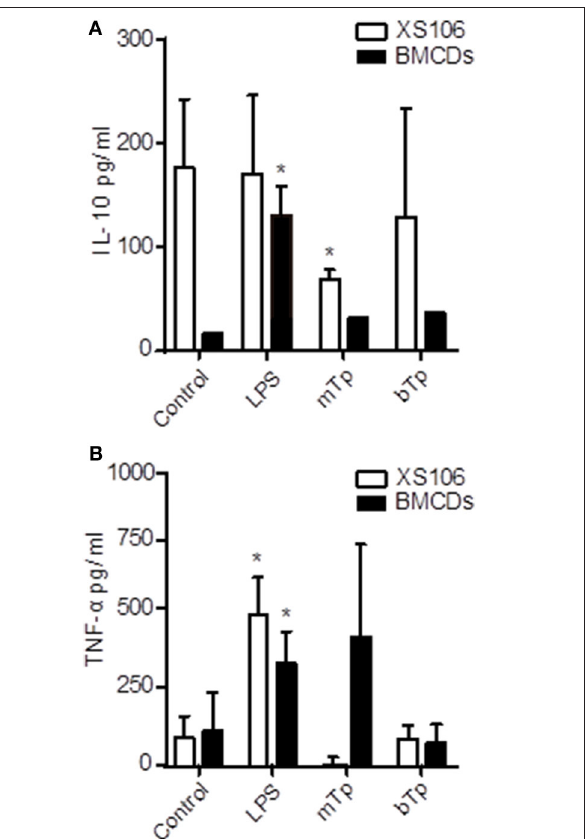
FIGURE 2 | Different IL-10 and TNF- α production patterns in XS106 cell line and BMDCs. 5 x 10 5 XS106 cells or BMDCs were incubated for 24h in 10-IMDM (control), LPS, bTp or mTp at a parasite to cell ratio of 4. IL-10 (A) and TNF- α (B) were measured in culture supernatants by ELISA. ND, not detected. The results are presented as the mean ± SEM of seven independent experiments, * p < 0.05 (compared to the respective control). One-way ANOVA and Dunnett’s post